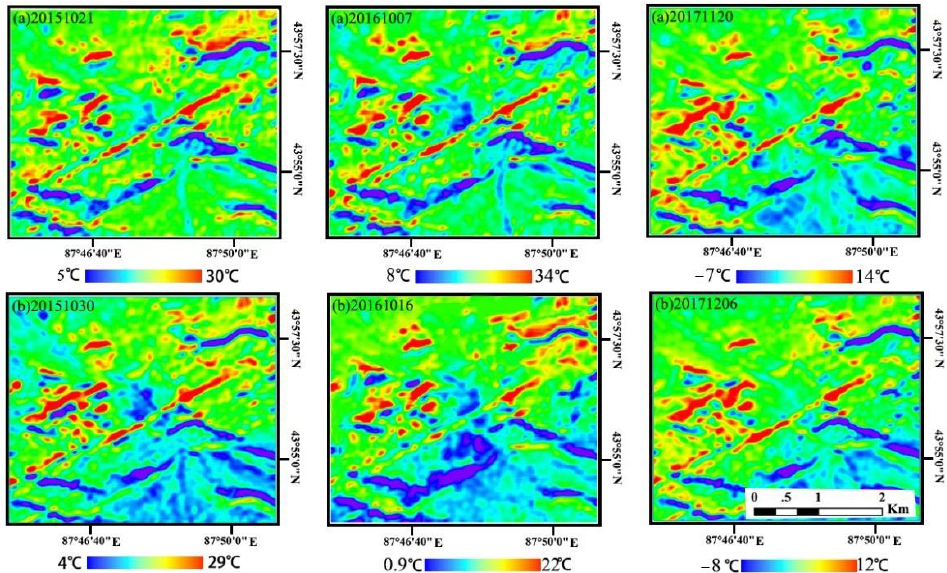
Figure 6. Ground temperature inversion results of the study area from 2015 to 2017.